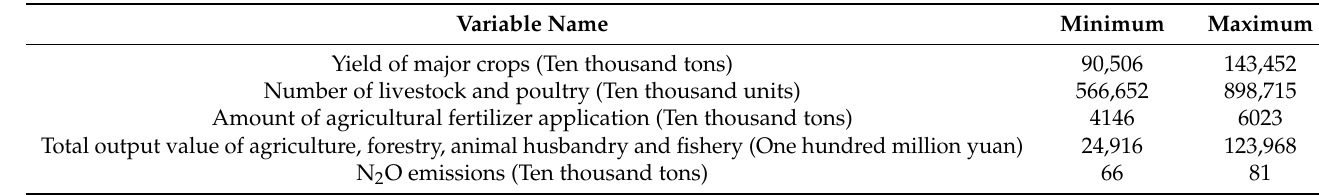
2 O emissions in